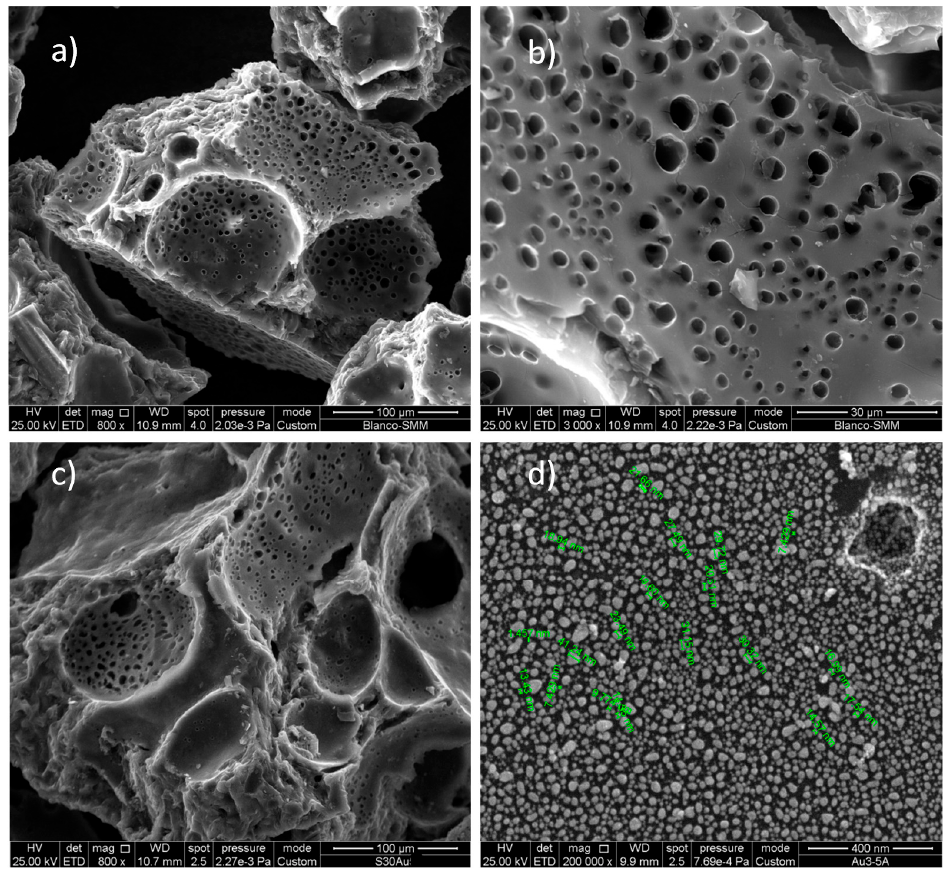
Figure 3. Scanning electron microscope (SEM) micrographs of CF at lower ( a ) and higher ( b ) magnification where a macroporous structure is observed and CF-Au at lower ( c ) and higher ( d ) magnification. Note: ( d ) migrograph allows the identification of the gold particles on the surface.